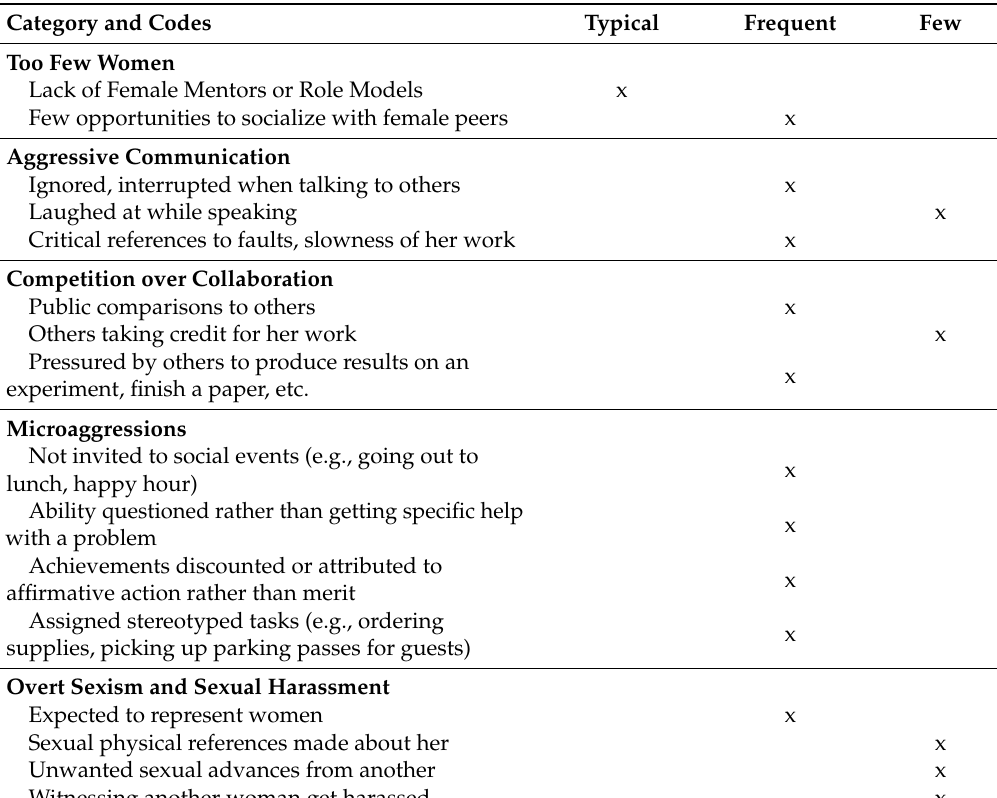
Table 3. Incidents Suggestive of a Social, Academic Culture Alienating to Women.